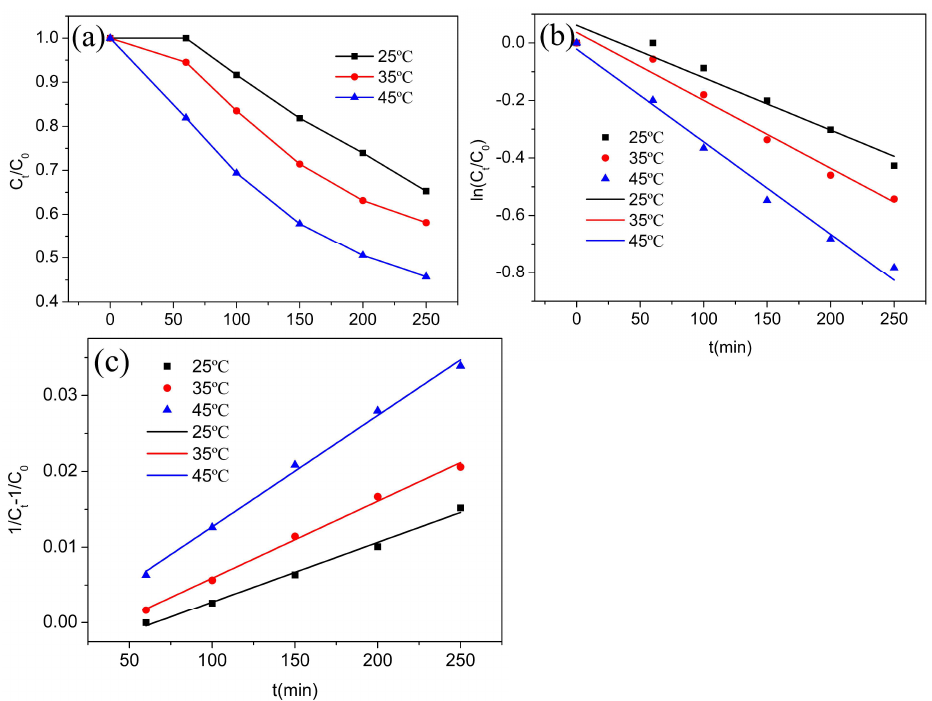
Figure 6. ( a ) Removal of terramycin in the rGO-coated CuFeO 2 /H 2 O 2 system at varying tempera- tures; ( b ) pseudo-first-order kinetics; and ( c ) pseudo-second-order kinetics. Table 2. The pseudo-first-order kinetics and pseudo-second-order kinetics fitting parameters. Kinetics